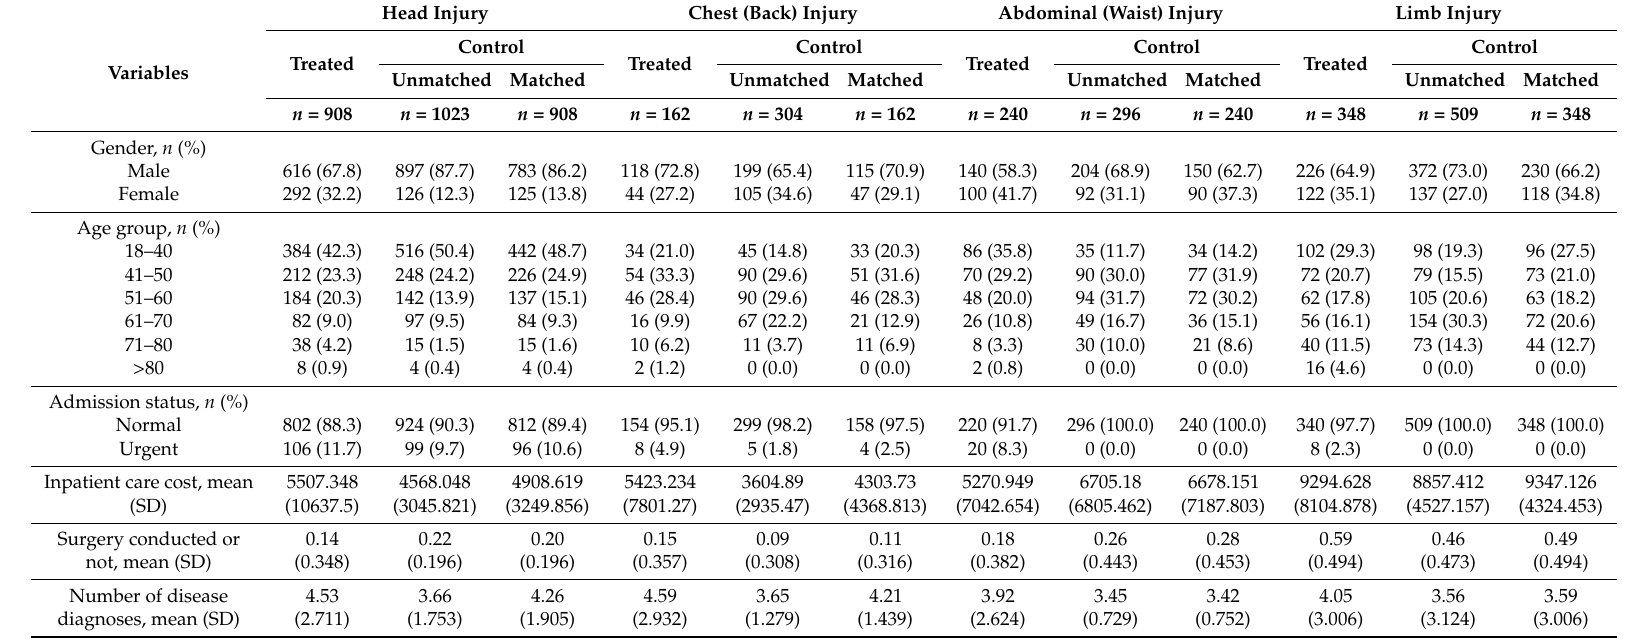
Table 2. Descriptive statistics of patient characteristics before and after propensity score matching in different